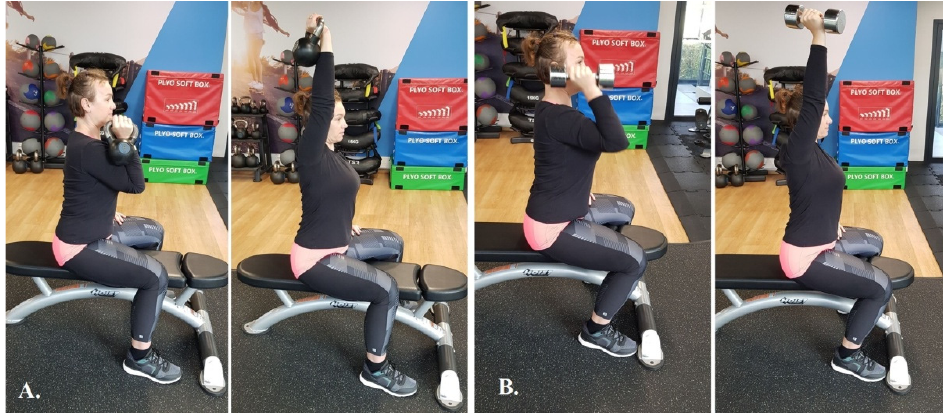
Figure 1. Kettlebell and dumbbell overhead press. ( A ) Starting and final position for kettlebell overhead presses; ( B ) starting and final position for dumbbell overhead presses.